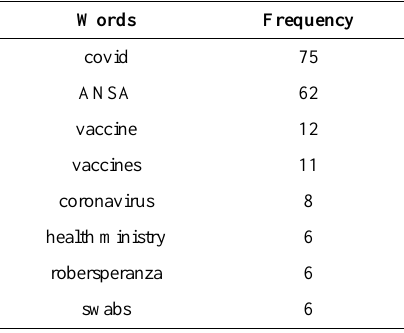
Table 11. Frequency of the most common words for positive peaks